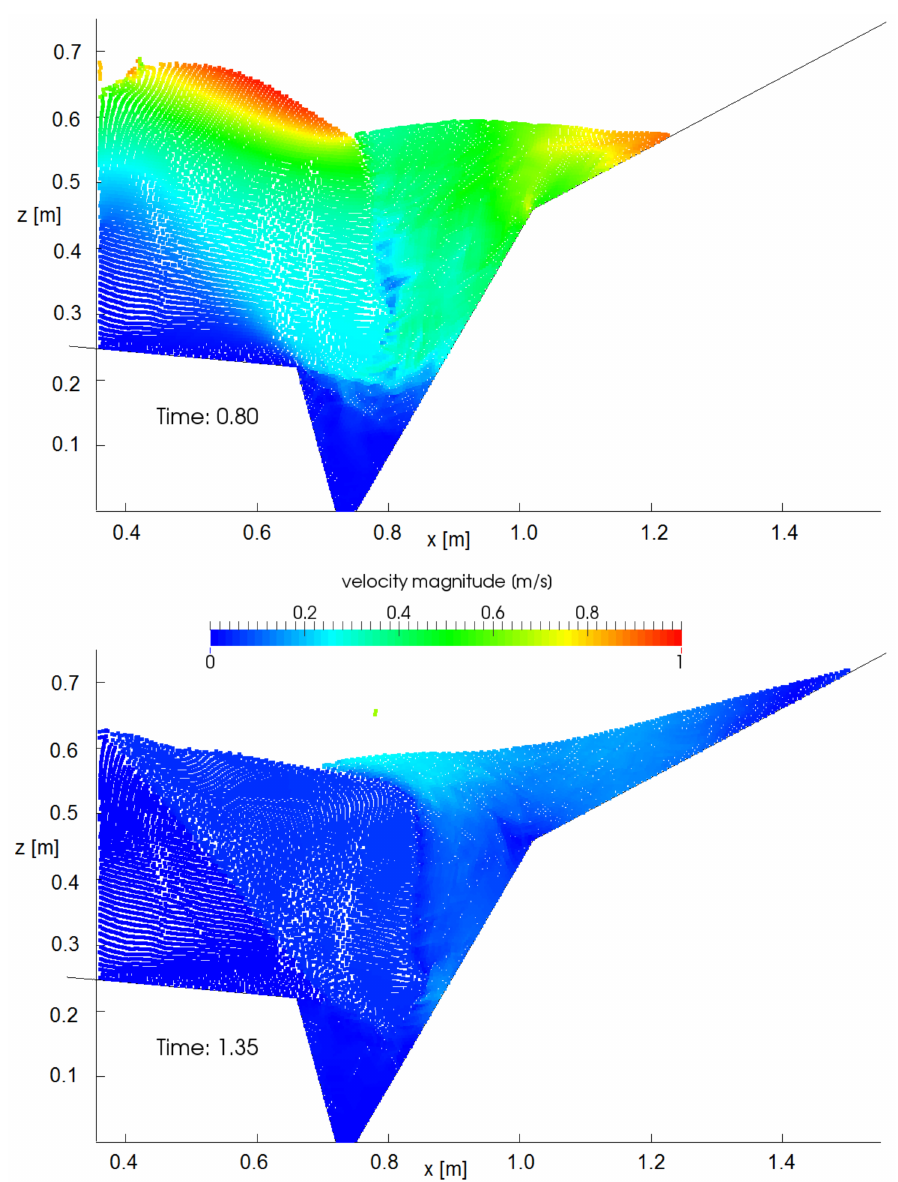
Figure 10. Velocity magnitude for reference Run V1 at: t = 0.80 s ( top ); and t = 1.35 s ( bottom